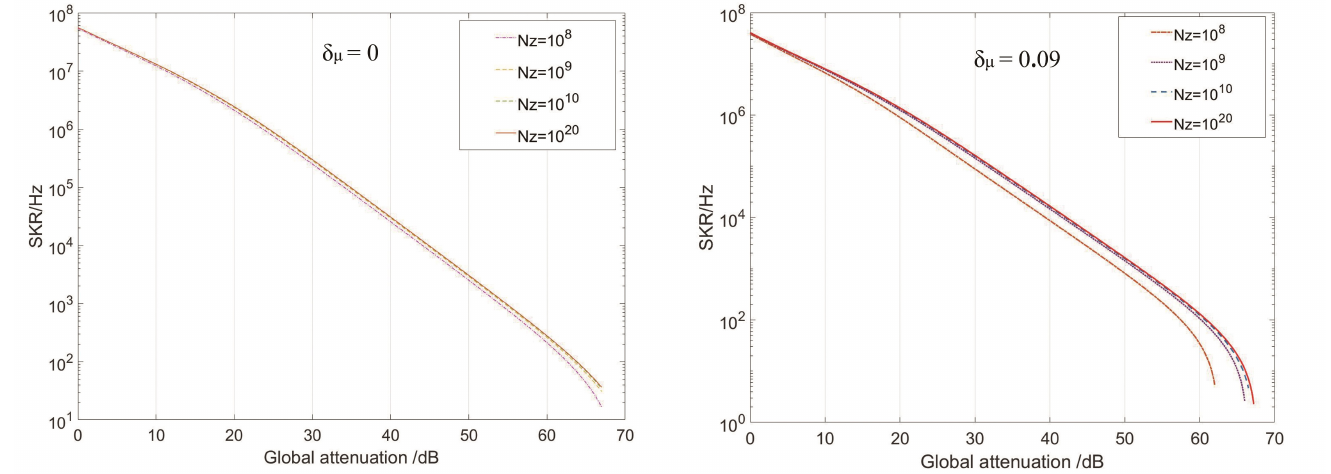
Figure 1. (Color online) Secret key rate vs. global attenuation for N Z = 10 8 ,10 9 ,10 10 ,10 20 with δ µ = 0, 0.09.